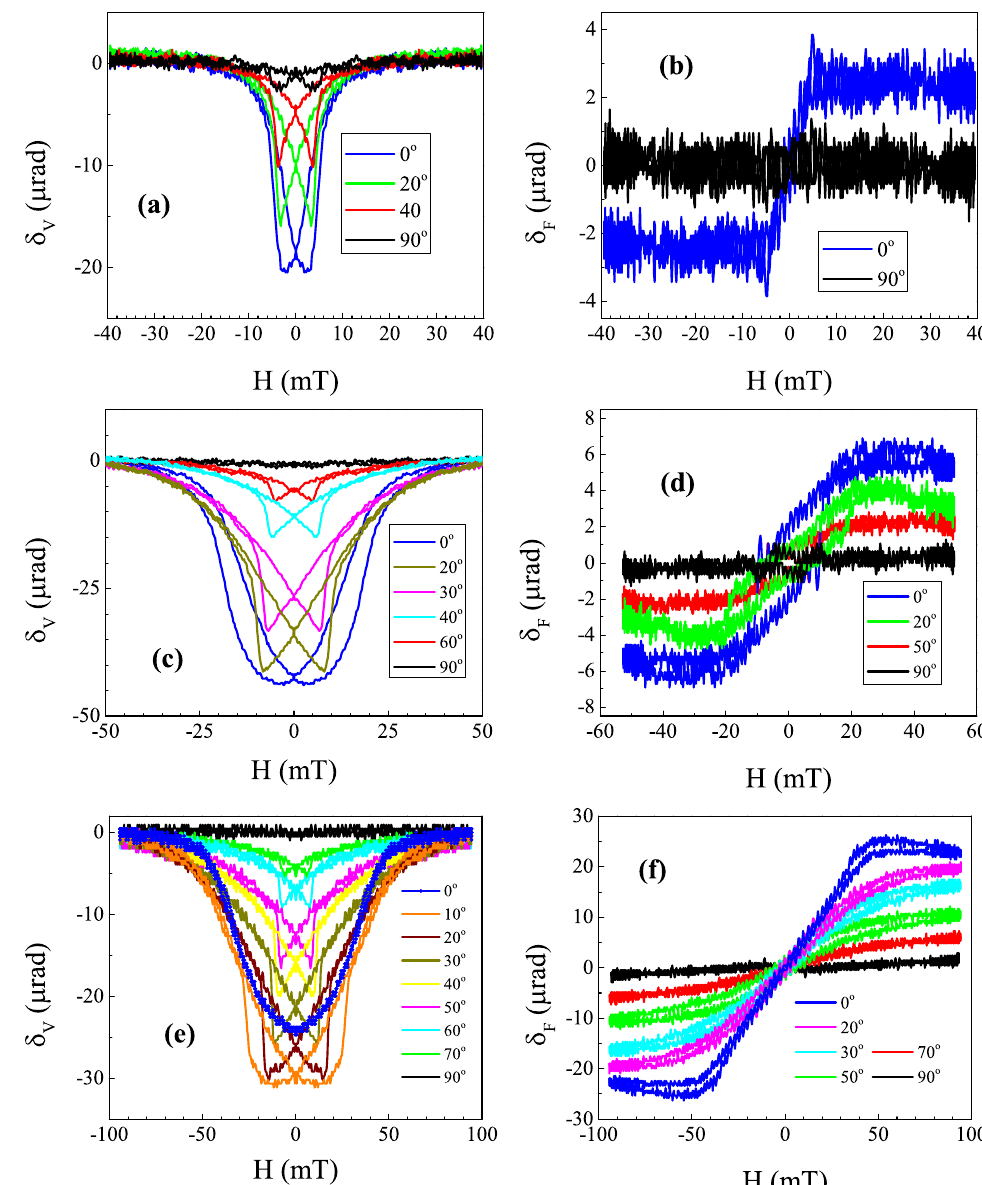
Figure 9. Dependence of Voigt and Faraday rotation angle on the magnetic field and Φ angle for three locations on the Co nanocluster assembly: Panels ( a , b ) correspond to P6, panels ( c , d ) to P4, and panels ( e , f ) to P3, respectively. In all cases, Φ value is indicated in each